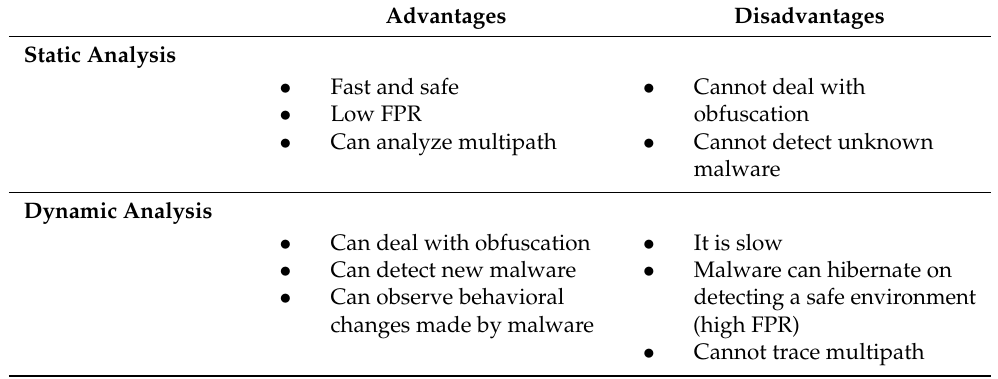
Table A1. Comparative Analysis of static and Dynamic Approaches to Malware